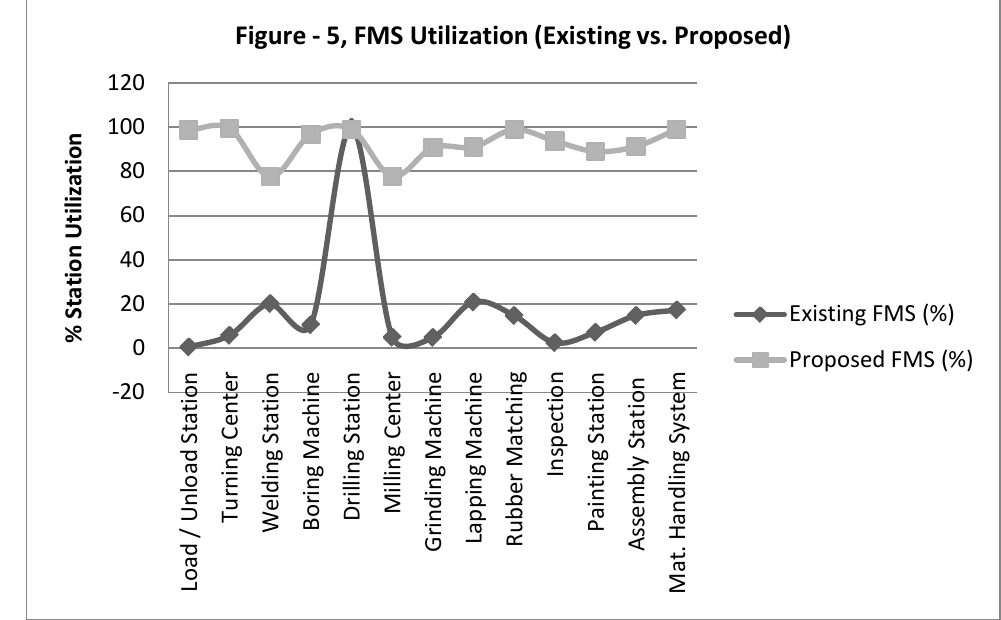
Figure - 5, FMS Utilization (Existing vs.